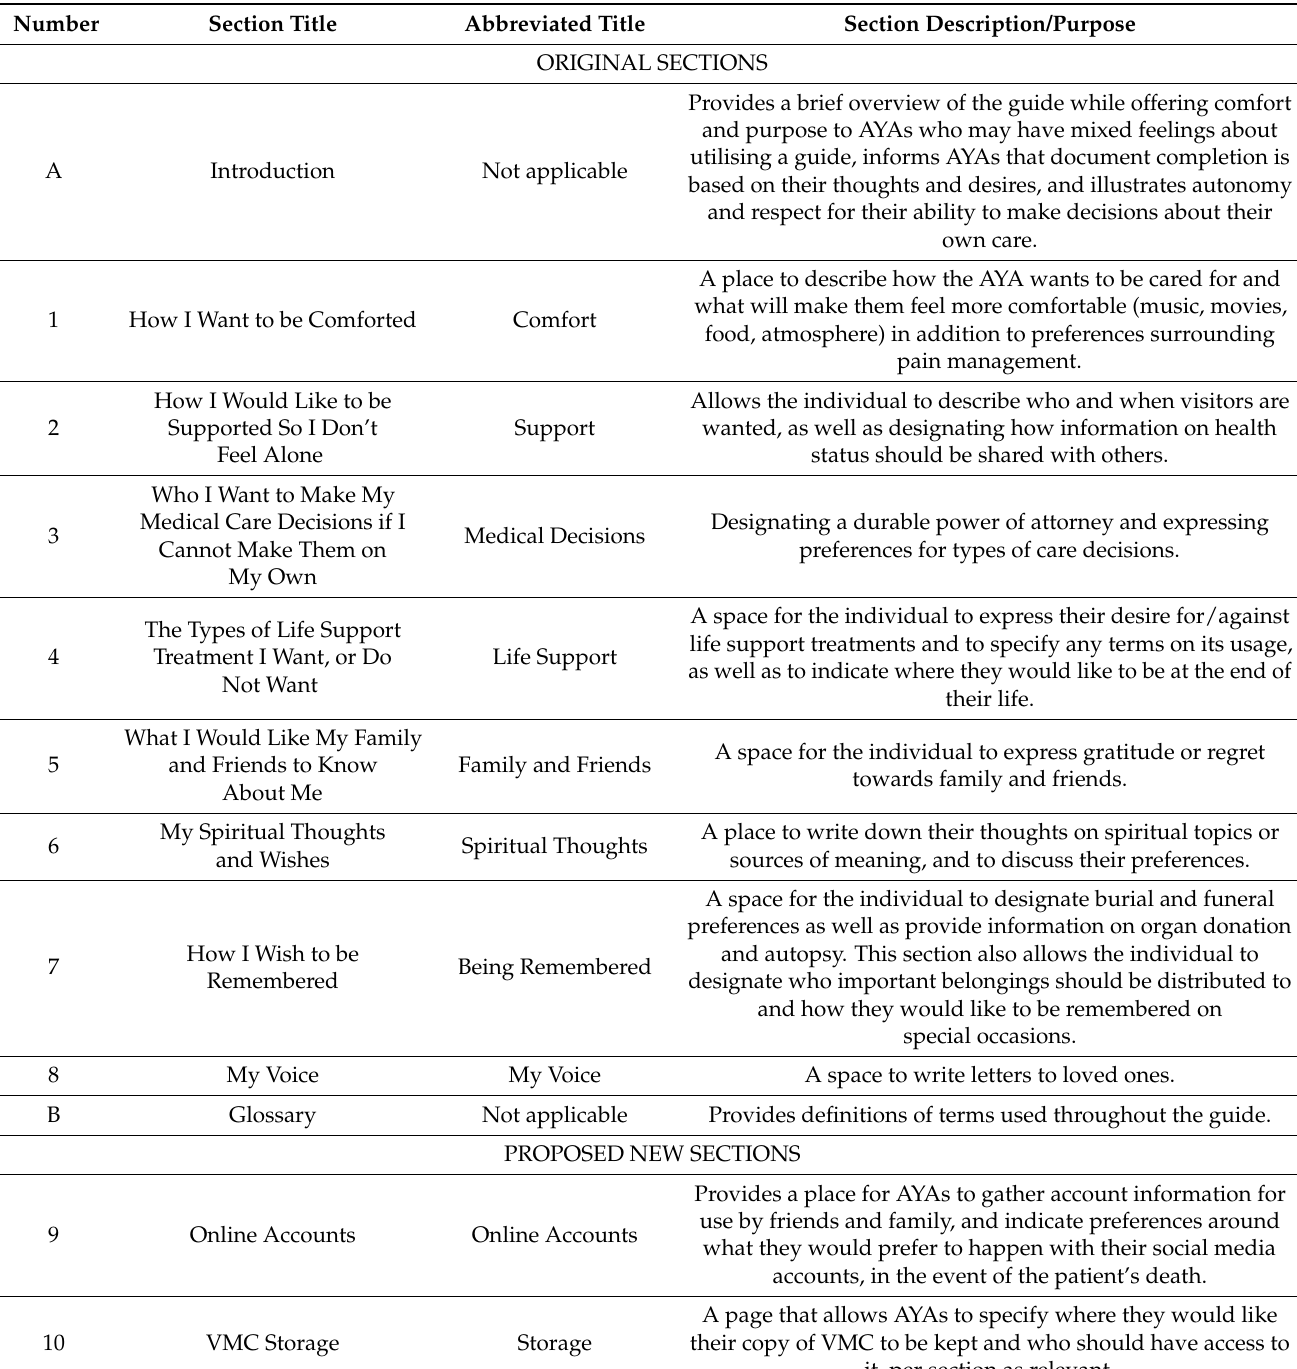
Table 1. Sections of the original American Voicing My Choices (used with permission from Wiener et al., 2021 [27]) and the two additional proposed